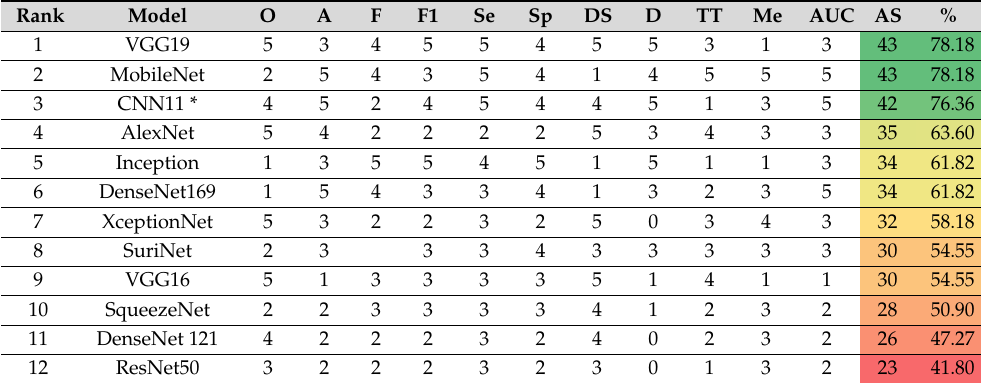
Table 4. Ranking table of the AI models. The background color tells about the intensity of the clas- sifier. Rank Model